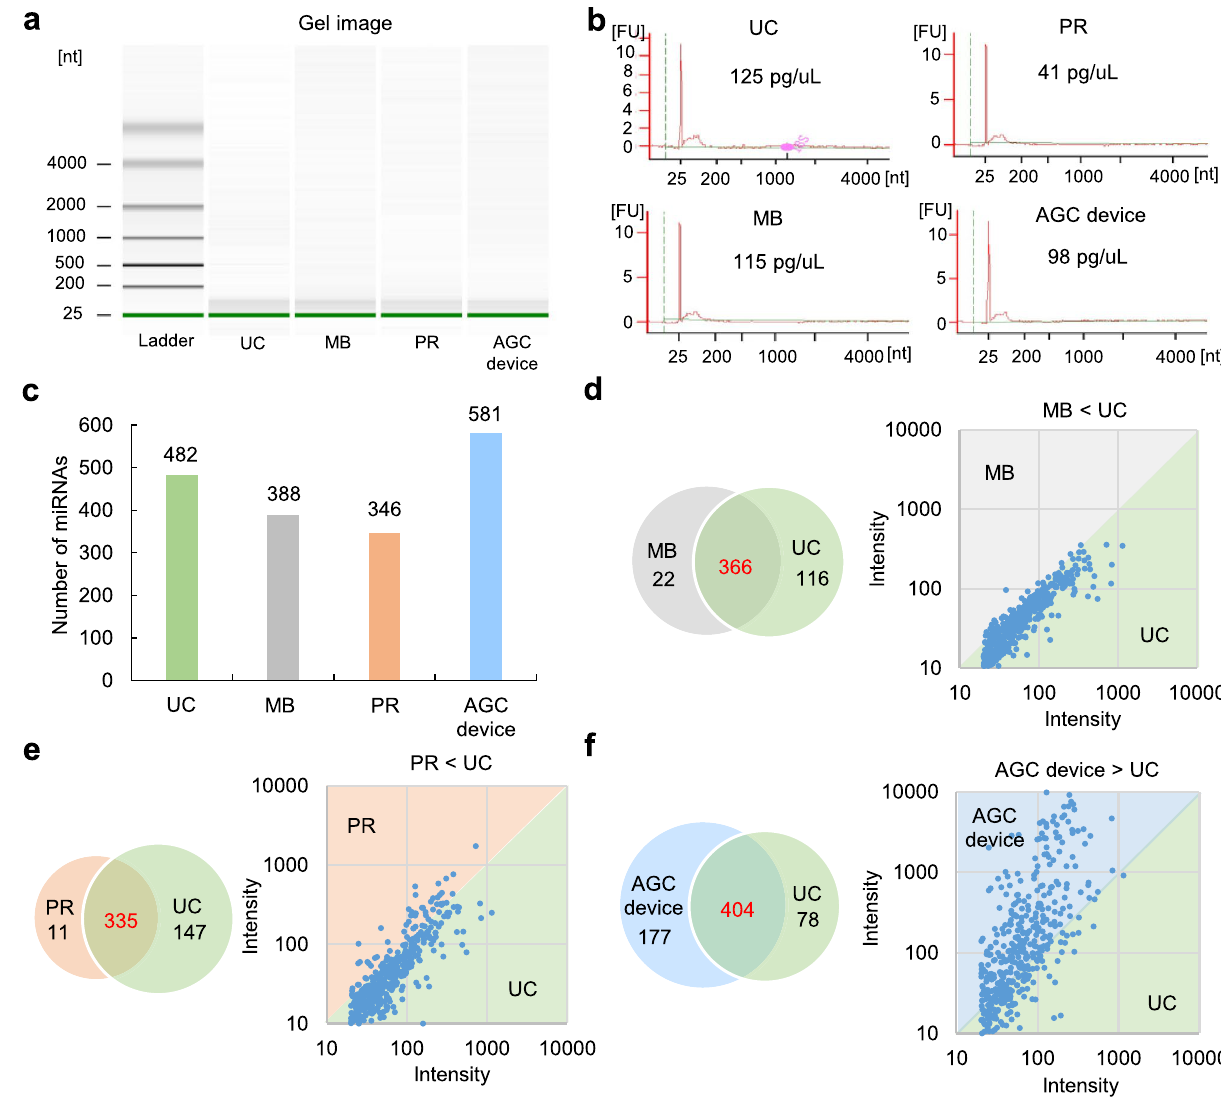
Figure 5. The miRNA array analysis of EVs collected from human urine. ( a ) A gel image of nucleotides [nt] of total RNA extracted from EVs collected from human urine using four EV collection methods (UC, MB, PR, and the AGC device) measured by a 2100 Bioanalyzer. ( b ) The concentration of total RNA extracted from EVs collected from human urine using four EV collection methods (UC, MB, PR, and the AGC device) measured by a 2100 Bioanalyzer. ( c ) The number of miRNAs extracted from EVs collected from human serum using four EV collection methods (UC, MB, PR, and the AGC device). ( d ) A venn diagram of the overlap of the number of detected miRNAs between UC (as the standard method) and the other three methods (MB [ d ], PR [ e ] and the AGC device [ f